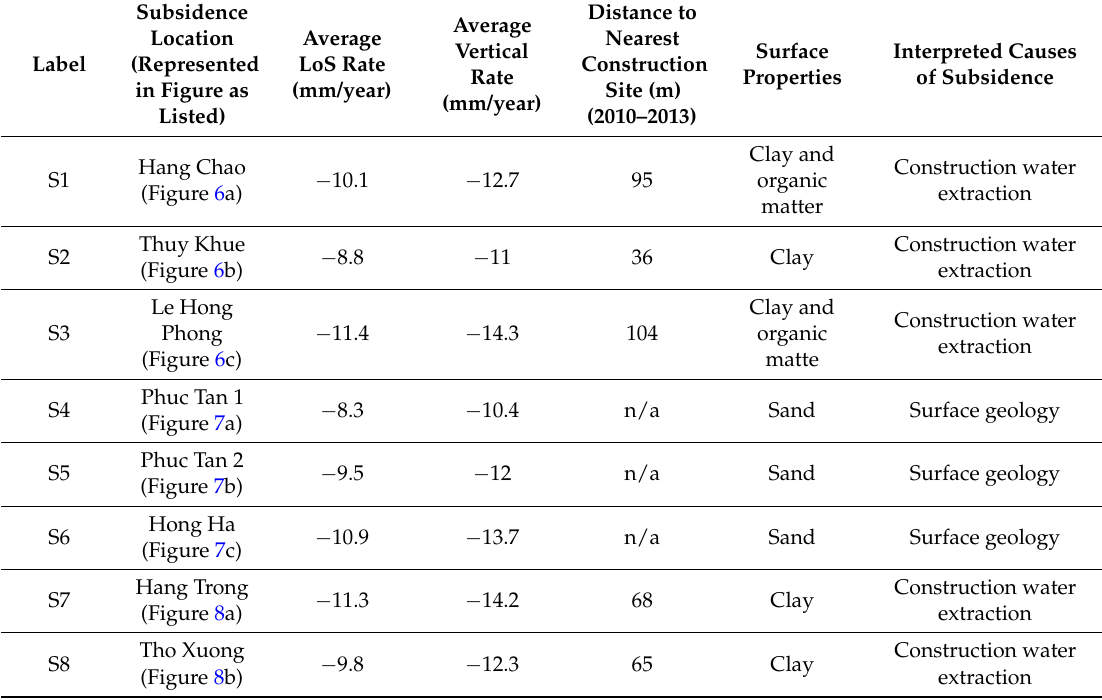
Table A2. The condition and interpreted causes of subsidence patterns observed in the Historical Centre of